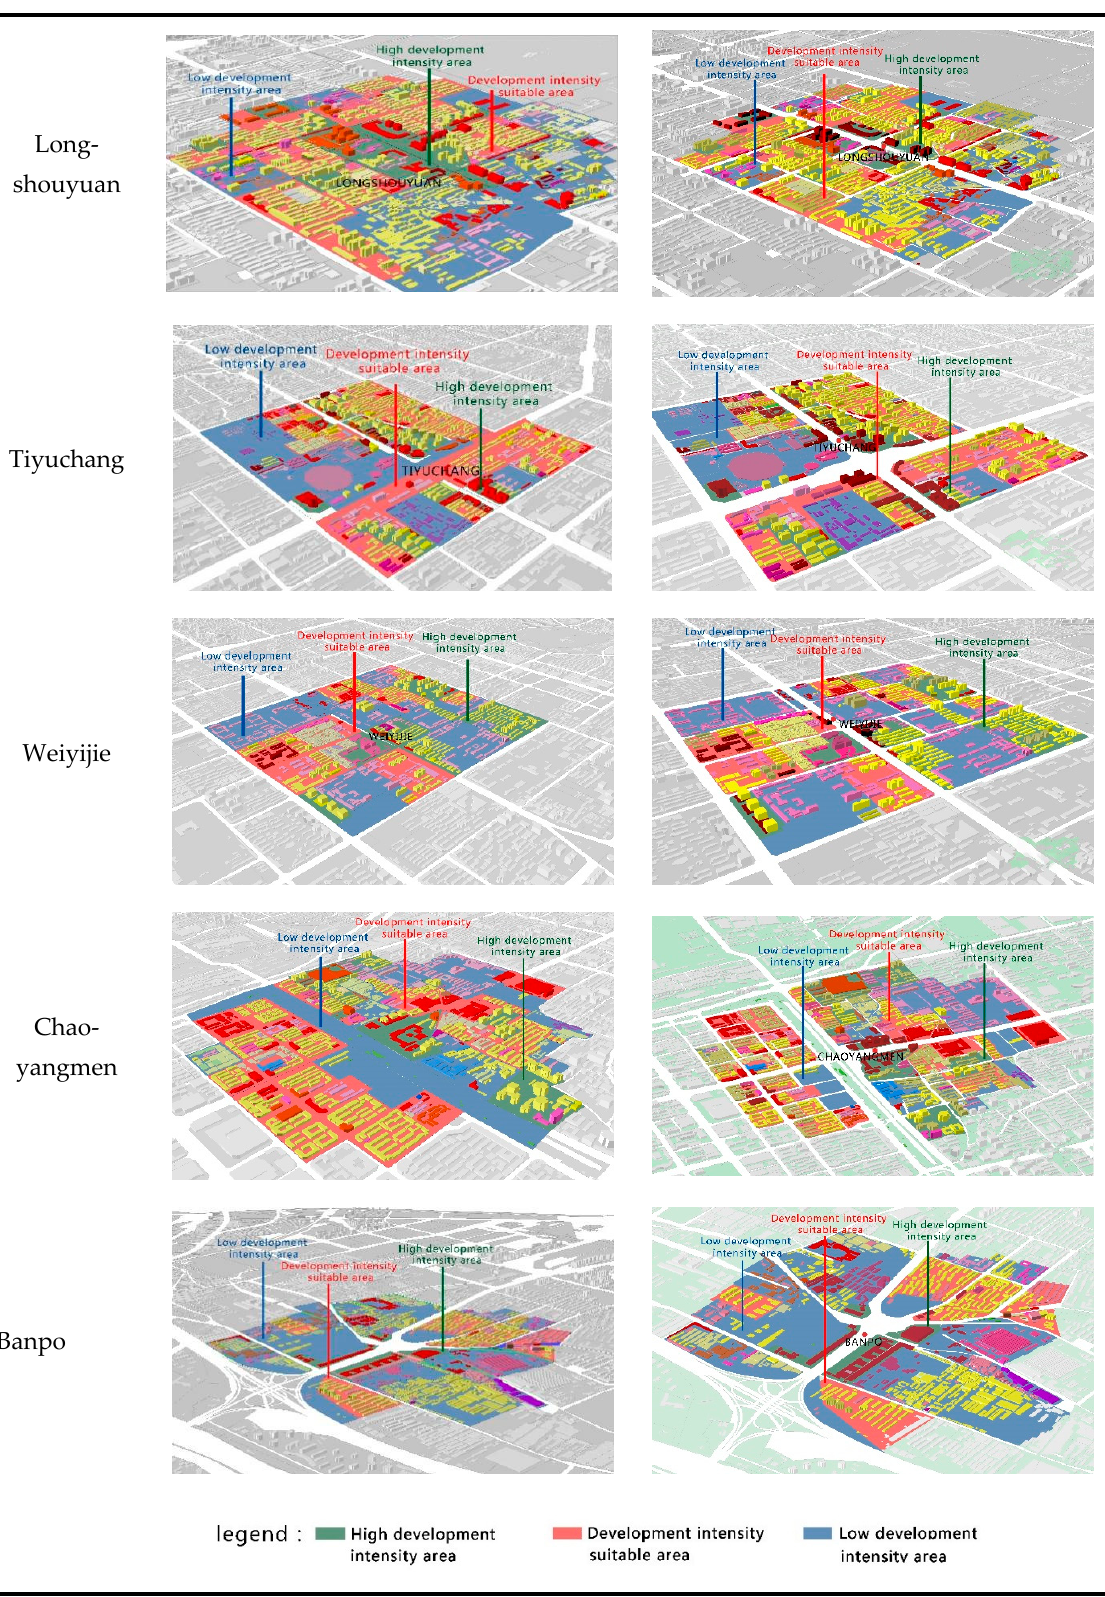
Figure 3. The development intensity zoning of each station and the spatial intention before and after optimization.